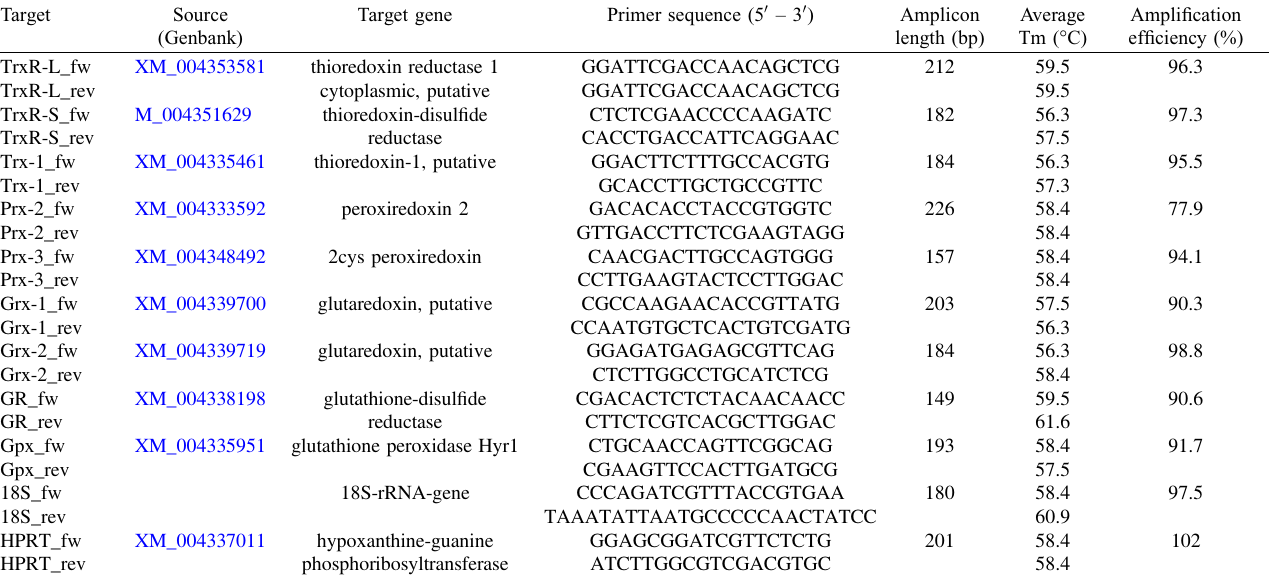
Table 1. Primers used for RT-qPCR in this study. Target Source